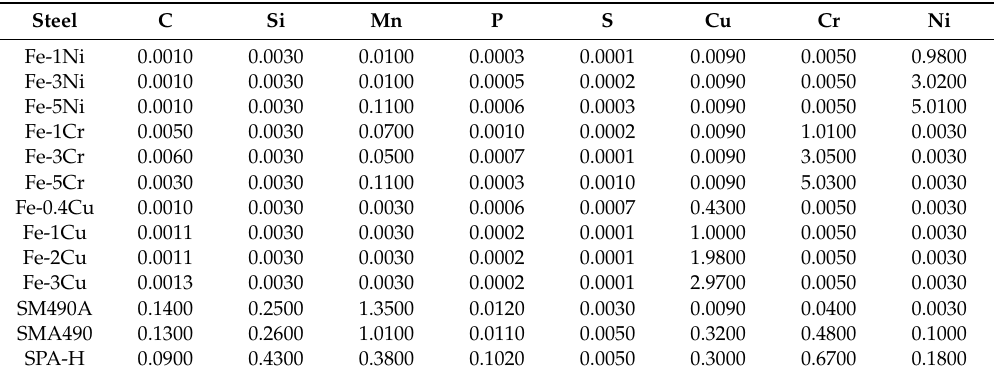
Table 1. Chemical compositions (wt.%) of selected low-alloy steel from the MatNavi database.